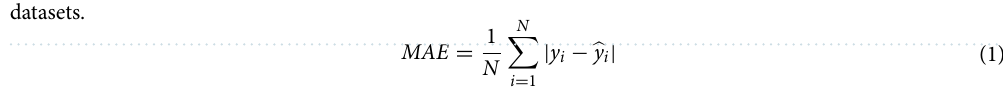
Figure 3. Scatterplots comparing the actual and predicted body weights in ( a ) chest and ( b ) abdominal